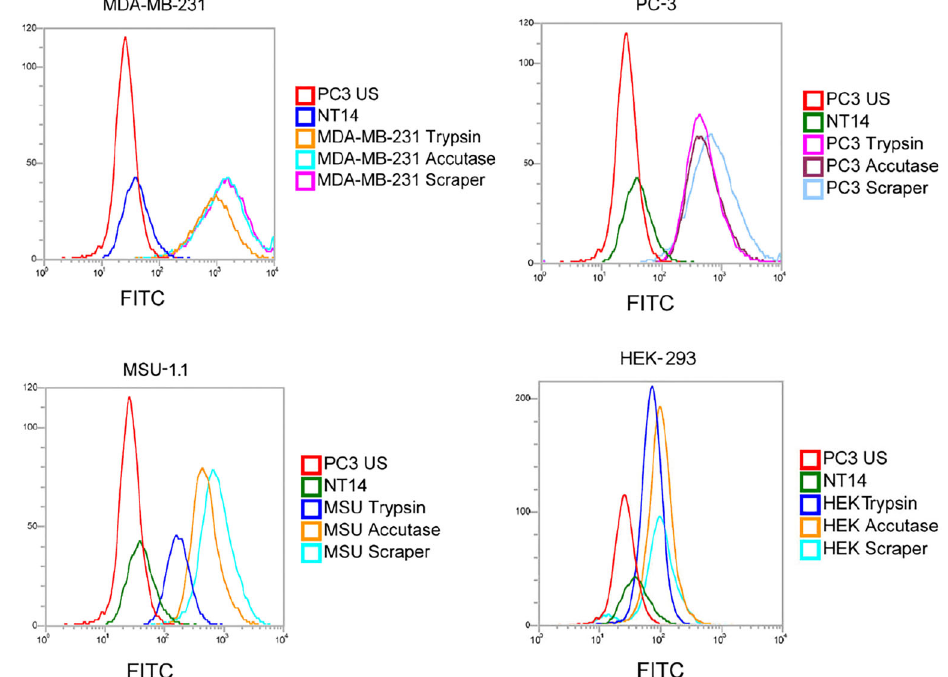
Figure 2. A representative result of fl ow cytometric analysis of different cell lines using different harvesting methods (trypsin, accutase treatment, scraping by rubber scraper). PC3 US: unstained PC-3 cells (negative control); NT14: wild type porcine cells (no expression of the human CD55, negative